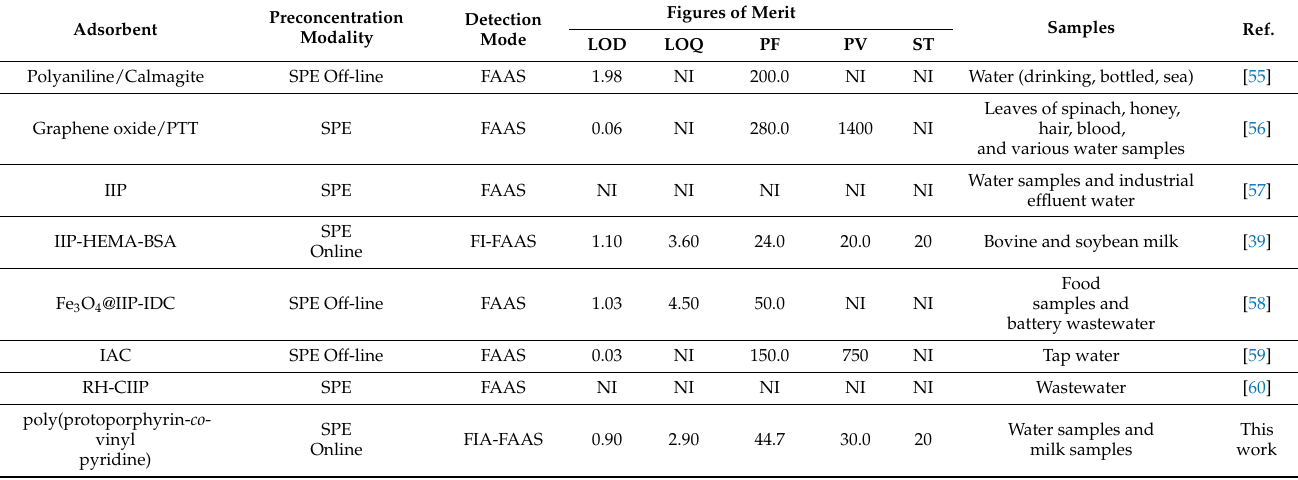
Table 1. Comparison of the analytical performance obtained by the proposed method with previously published methods using SPE for the determination of the Cu 2+ ion by FAAS